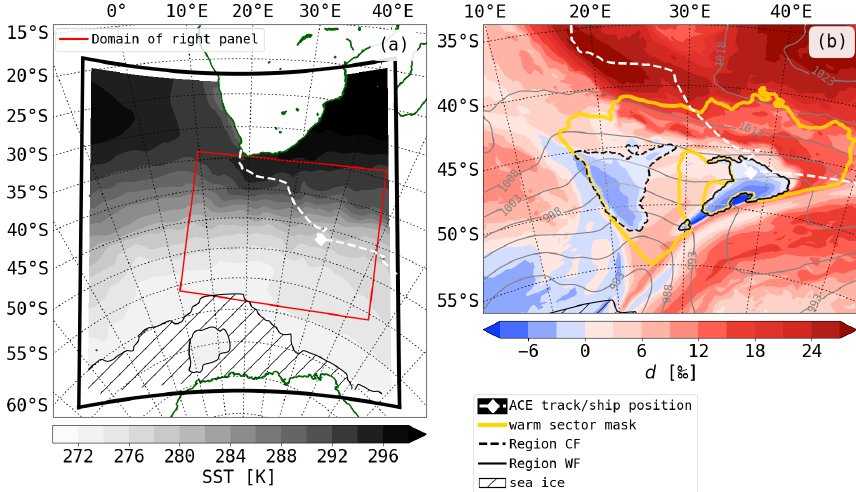
Figure 1. (a) Mean SST during the COSMO iso simulation; the model domain is shown by the thick black line, and the selected subregion in panel (b) is shown with a red rectangle in panel (a) . (b) Simulated d on the lowest model level (filled contours) and sea level pressure at 22:00UTC on 26 December 2016 (grey contours, every 5hPa). Additionally, important regions for the case study are highlighted: the warm sector (yellow line), the region of low d behind the warm front (solid black line, region WF) and ahead of the cold front (dashed black line, region CF), and the ACE track (white dashed line; white diamond for the ship position at 22:00UTC on 26 December 2016).